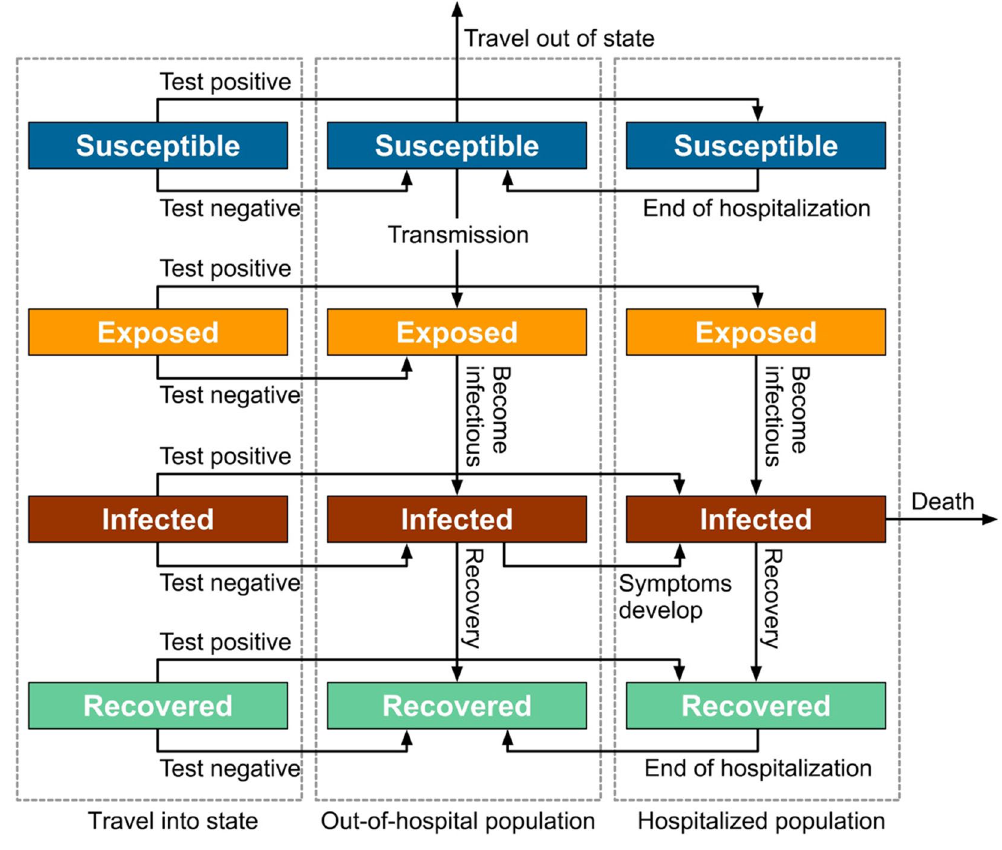
Figure 1. Kerala model structure. See Methods section for